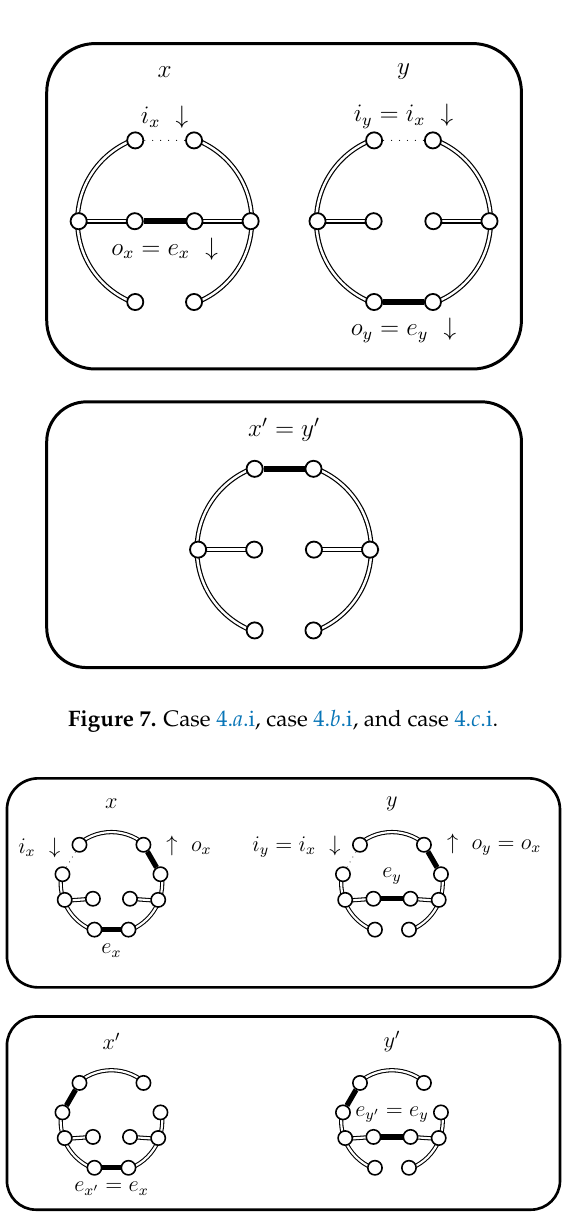
Figure 8: Case 4. a .ii, case 4. b .ii and case 4. c .ii, when o x /